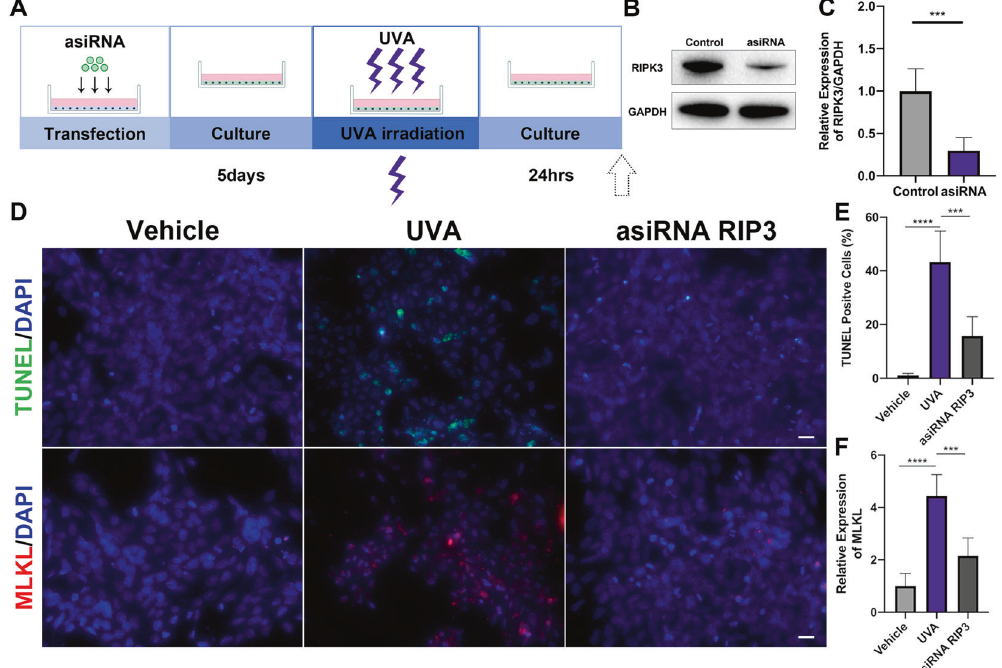
Fig. 4 Silencing of RIPK3 suppresses cell death via necroptosis pathway in pHCECs. A Flow chart of pHCECs transfection, culture, and UVA irradiation model. B, C Western blot analysis of RIPK3 in control and asiRNA RIPK3 transfected pHCECs. D Representative images of TUNEL (Green), MLKL (Red), and DAPI (Blue) staining in vehicle, UVA, asiRNA RIPK3 transfected pHCECs (Scale Bar: 20 μ m). E, F The TUNEL-positive cells (%) and MLKL fl uorescence intensity in normal pHCECs and UVA irradiation pHCECs were quanti fi ed (a total of 60 – 200 cells were selected for statistics in each group, n = 6 per group). Statistical signi fi cance was analyzed with the unpaired Student ’ s t -test . ** P < 0.01, *** P < 0.001 , **** P < 0.0001 . All values are expressed as mean ± SD.